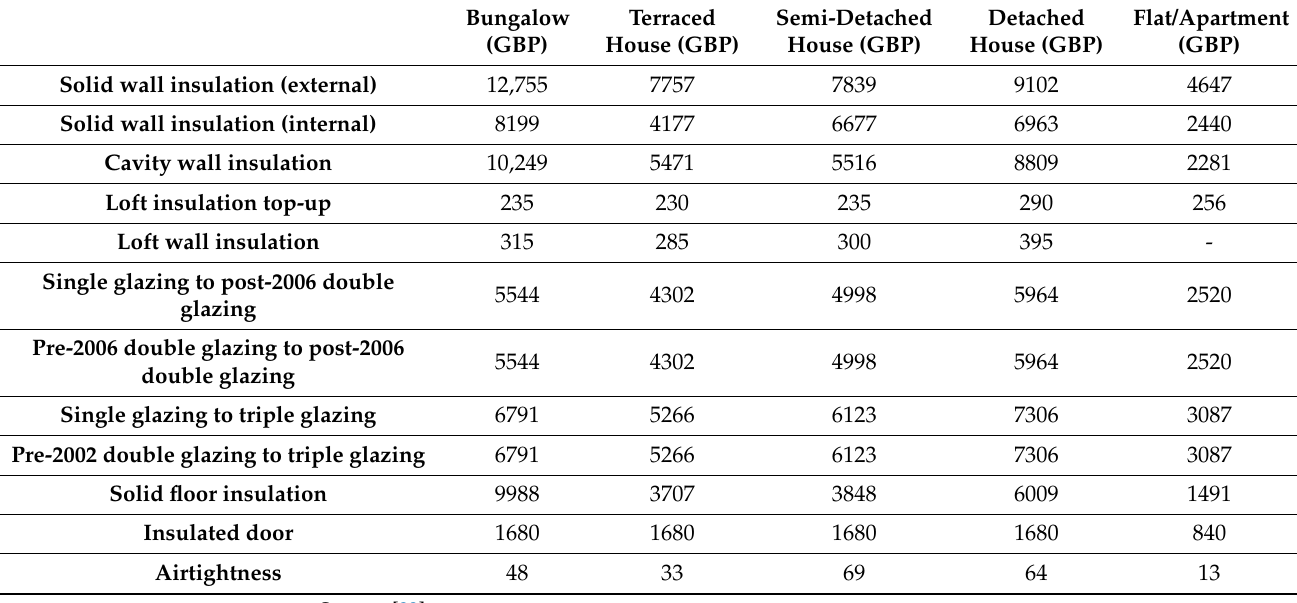
Table A2. Costofretrofitpermeasureperhousetype(applicabletoCentral,High-LevelandPassiveScenarios).